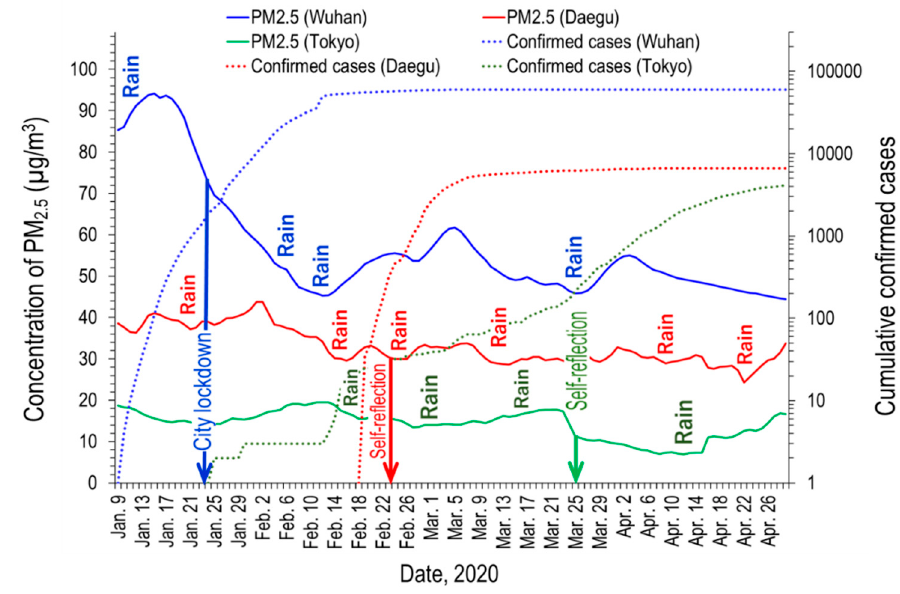
Figure 4. Daily variations of the concentration of PM 2.5 in Wuhan, Daegu, and Tokyo, with the cumulative confirmed cases of COVID-19.